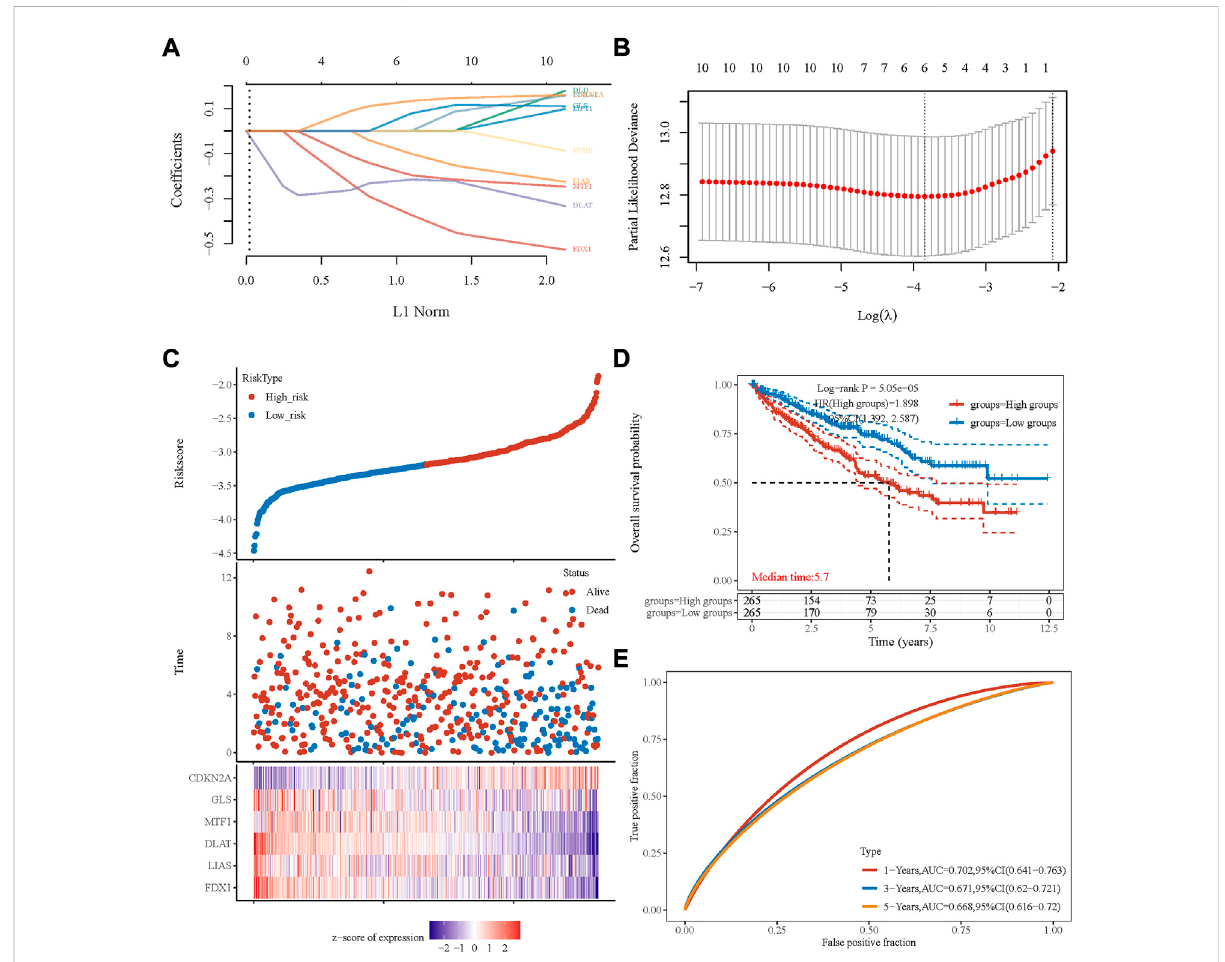
FIGURE 1 Prognostic signature was established based on six prognostic cuprotosis-related genes. (A) LASSO coef fi cient pro fi les of the genes associated with the cuprotosis of ccRCC. (B) Partial likelihood deviance is plotted versus log ( λ ). (C) The risk score of each sample is based on the cuprotosis- relatedsignature.Patientsweredividedintolow-riskandhigh-riskgroupsaccordingtothemedianvalueoftheriskscore.High/lowexpressionlevels of six genes, which were involved in the prognostic signature, are shown in red/blue in each sample. (D) Kaplan – Meier curve of overall survival differences strati fi ed by the signature risk score. (E) ROC curves of the signature for overall survival rates at 1, 3, and 5 years. LASSO, least absolute shrinkage, and selection operator; ROC, receiver operating